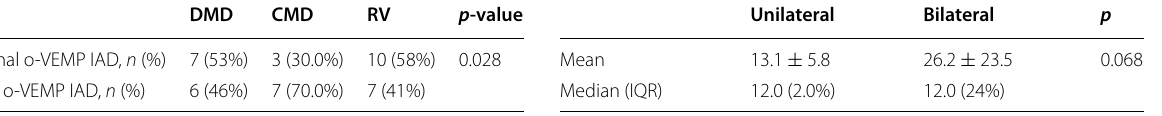
Table 12 Percentage of abnormal IAD of c-VEMP Table 16 Duration of symptoms in relation to laterality DMD CMD RV